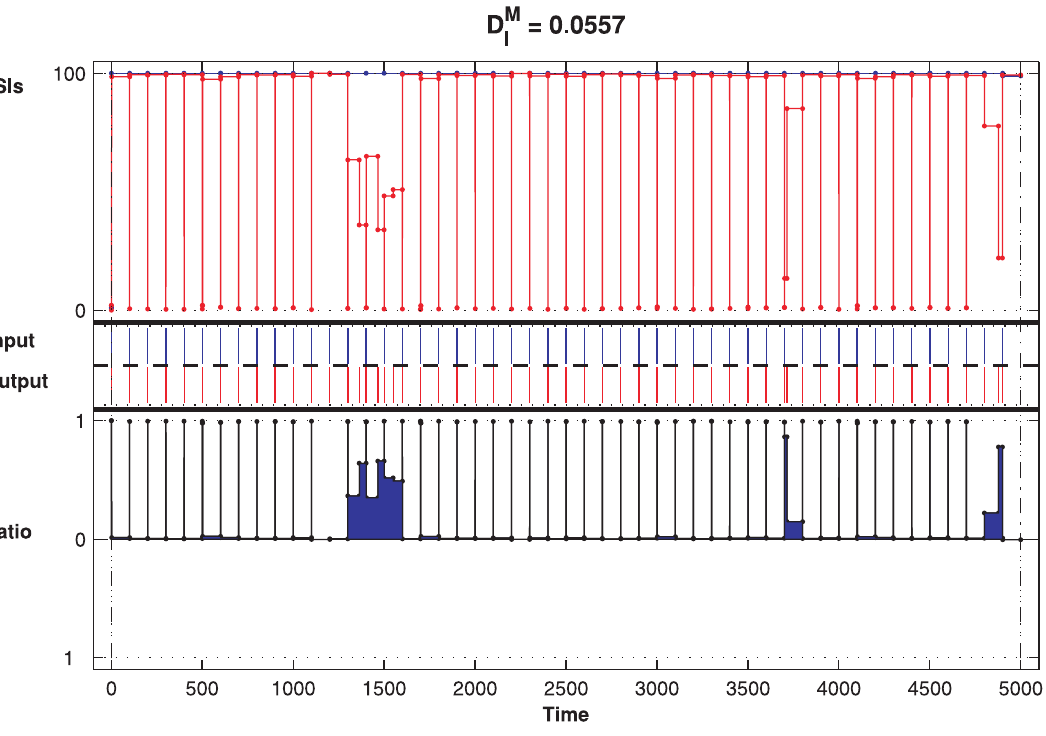
Figure 7. CD neuron fails to respond to the network input. For T w ~ 2 : 0 ms and h ~ 20 , the blue color denotes that the CD neuron cannot detect the synchrony of its inputs properly and the response is faster.